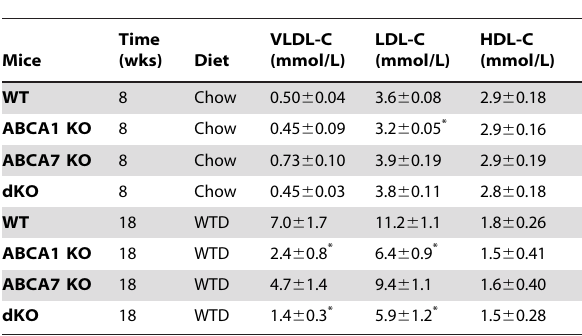
Table 2. Serum cholesterol levels in WT, ABCA1 KO, ABCA7 KO and dKO bone marrow transplanted mice on chow and